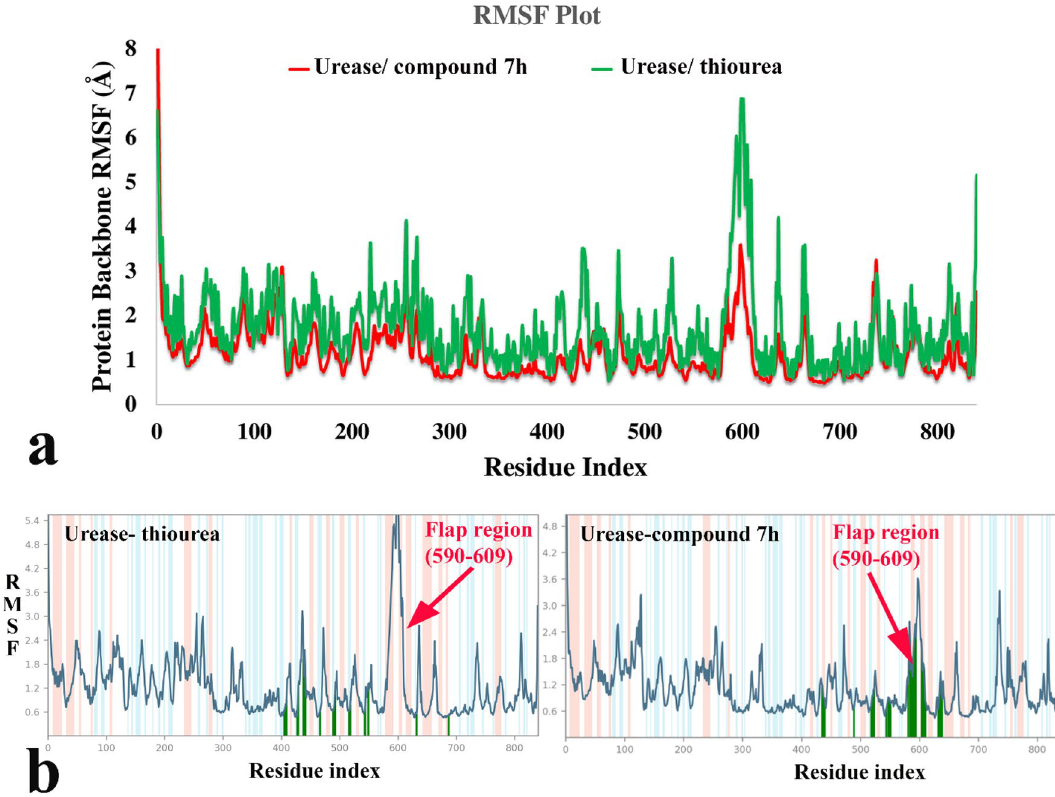
Figure 9. RMSF of the urease backbone in complexed with thiourea (in green) and compound 7h (in red) ( a ), ligand binding location for over 100 ns MD simulation time; ( b ) α-helical and ß-strand regions are highlighted in light red and blue backgrounds, respectively. The molecular graphic in this figure was generated using VMD depict lower RMSF value while loops with loosely organized structure have high RMSF value. Comparing RMSF values of urease-compound 7h complex shows that it has obviously lower value through the whole part of the